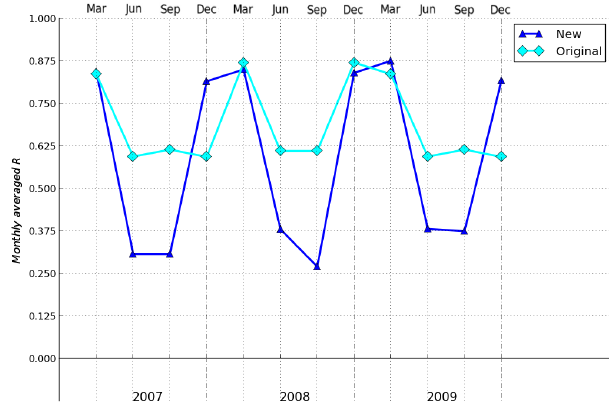
Figure 7. Correlation for the original and the new AMSU-B TWV retrievals with ECMWF